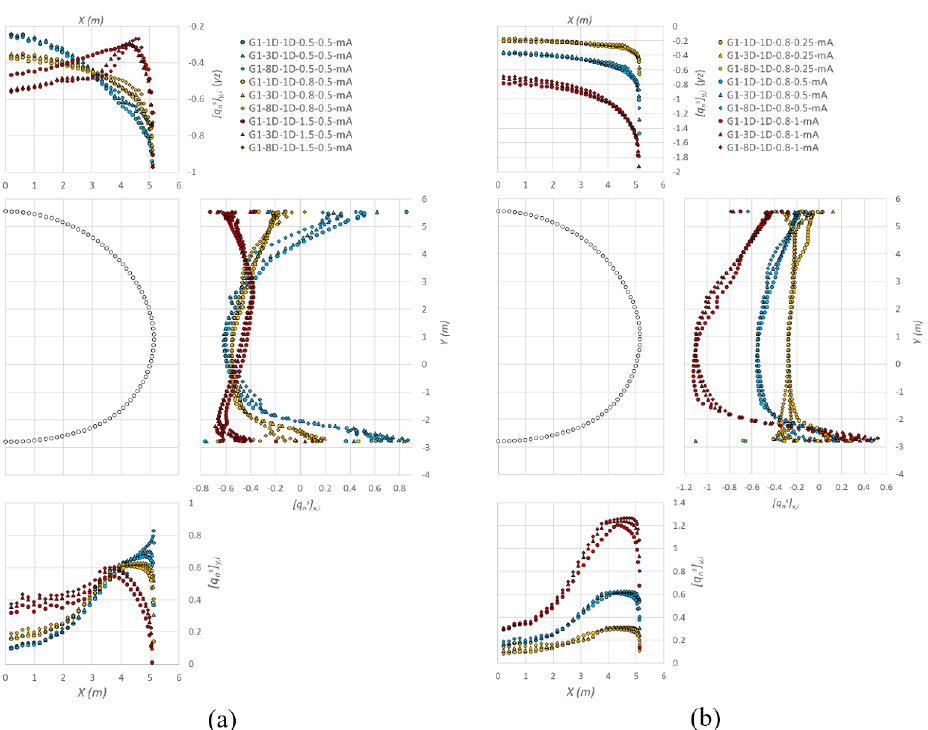
Figure 9. Normalized “ideal” compatibilization load for scenarios varying: (a) cover and 0 K in geometry G1; (b) cover and β for geometry